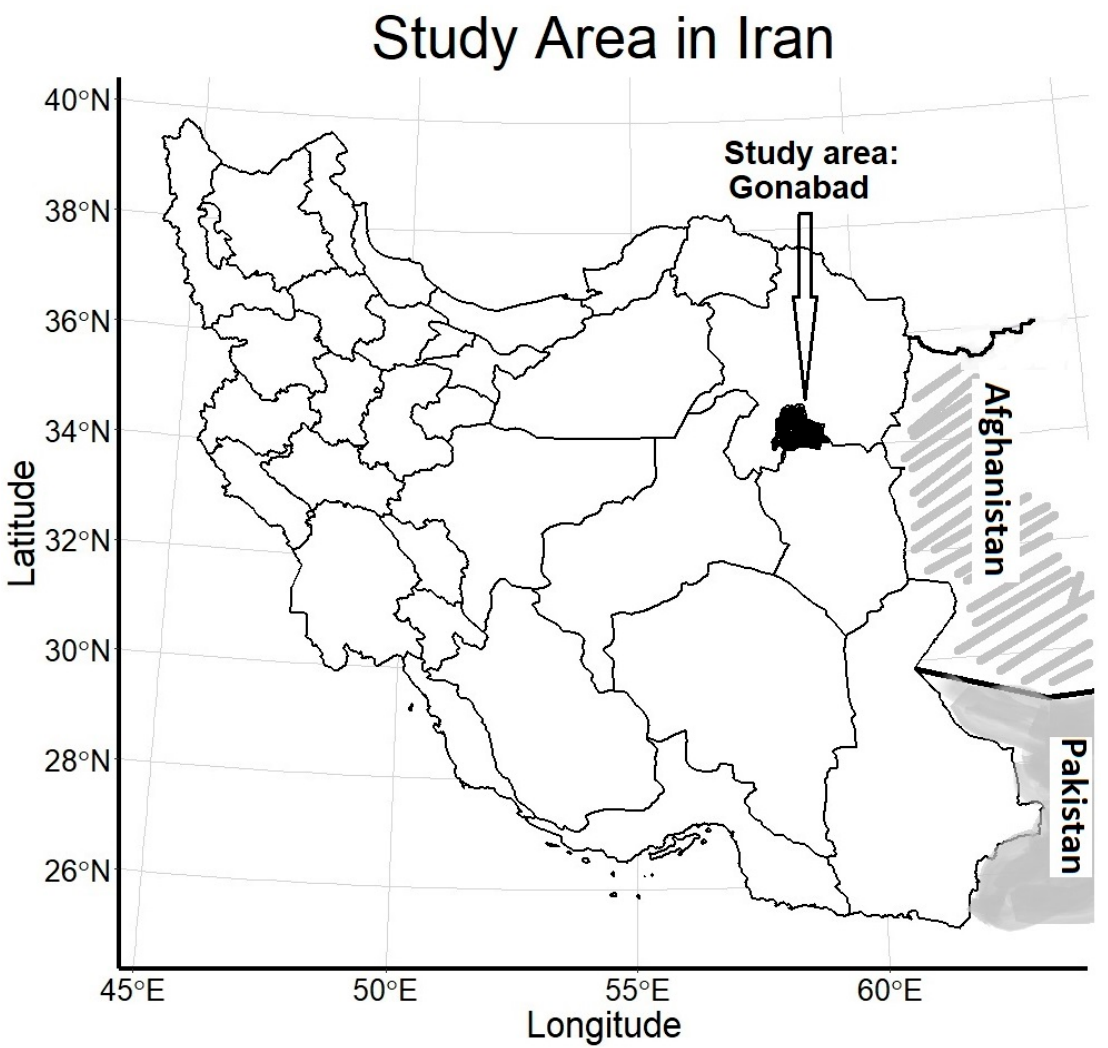
Figure 1. The map of the study area (own elaboration with the help of the ggplot2 package in R [31])